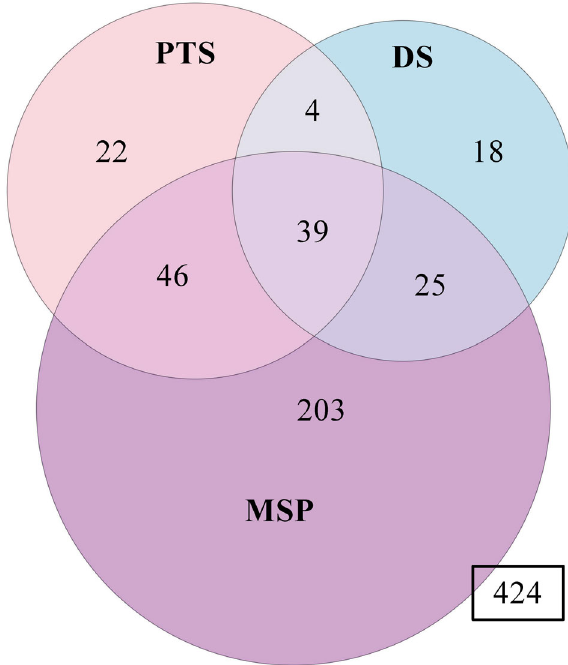
Fig. 1 Overlap in posttraumatic stress (PTS), depressive symp- toms (DS), and musculoskeletal pain (MSP) outcomes 6 months following motor vehicle collision trauma in White individuals ( n = 781). Clinical overlap between common adverse posttraumatic neuropsychiatric outcomes is represented here via Venn Diagram. In total, 357 (46%) participants experienced at least one outcome and 424 participants reported full recovery (i.e., no PTS, DS, or MSP). Of those individuals experiencing at least one outcome, 32% ( n = 114/ 357) reported two or more outcomes and 11% ( n = 39/357) reported all three outcomes. Further details/summaries are presented in the main body of the manuscript.